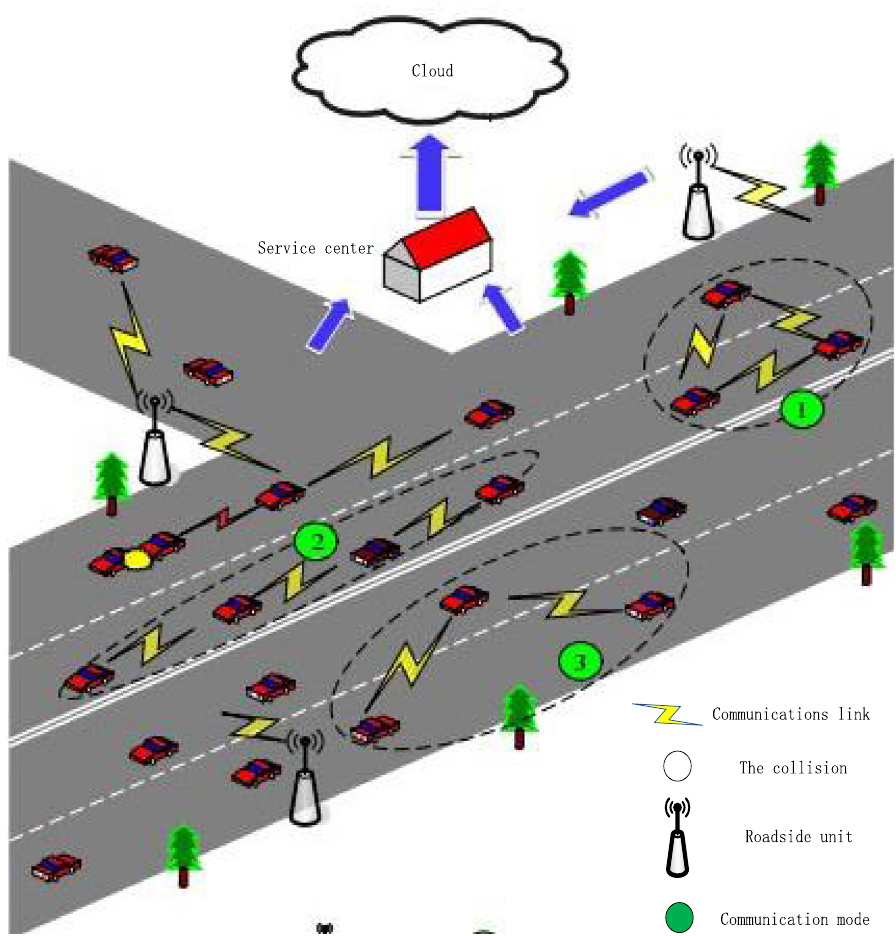
Figure 3: Schematic diagram of vehicle networking